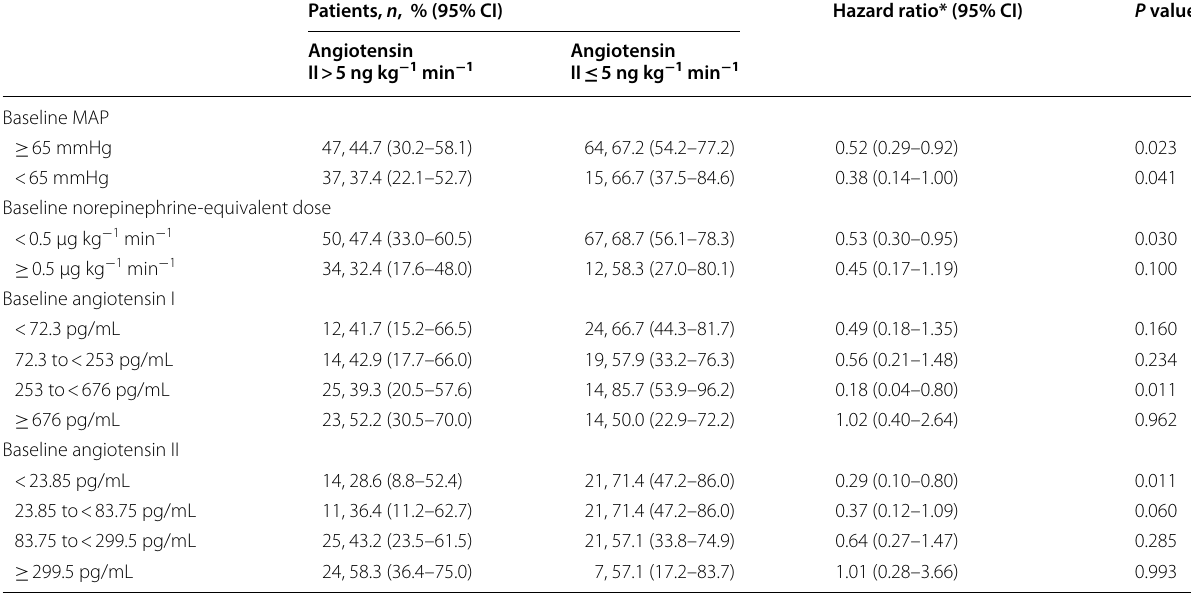
Table 3 Univariate analysis of survival at day 28 for baseline covariates significantly different between the angiotensin II dose groups